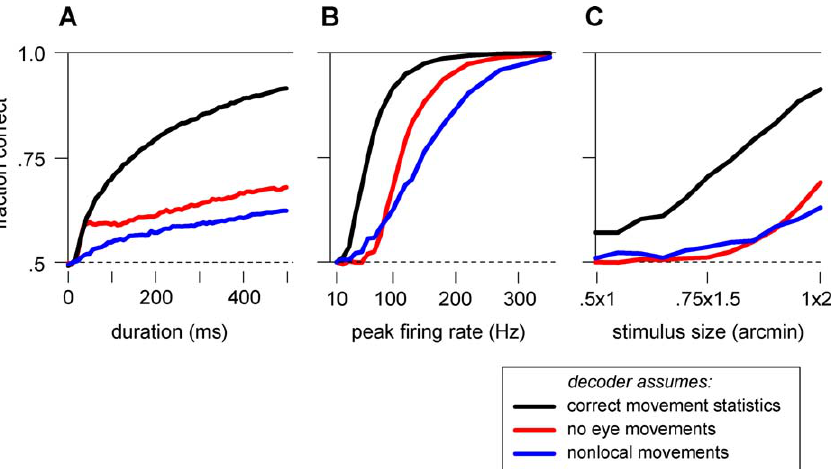
Figure 5. Model Performance on the Horizontal versus Vertical Discrimination Task Shown in Figure 2 Performance is measured by simulating retinal responses, calculating decisions based on those responses, and computing the fraction of correct decisions (see Materials and Methods). When fixational eye movements jitter the stimulus, the Markov decoder is able to perform well on the task by accounting for the eye movement statistics (black curves). Two naive decoders are also applied to this task, one that assumes the stimulus is fixed (red) and one that assumes maximum uncertainty about those movements (blue). Performance is shown as a function of stimulus duration (A), peak stimulated firing rate (B), and stimulus size (C). Where not otherwise specified, the parameters for these simulations are background firing rate of 10 Hz, a peak stimulated rate of 100 Hz, a stimulus of 1 3 2 arcmin 2 , a duration of 500 ms, and a diffusion constant of 100 arcmin 2